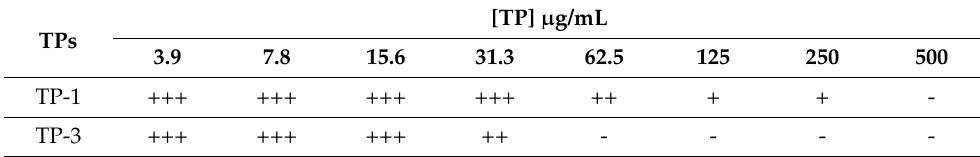
Table 2. Effect of TP-1 and TP-3 on S . mutans using spot-plating assay.